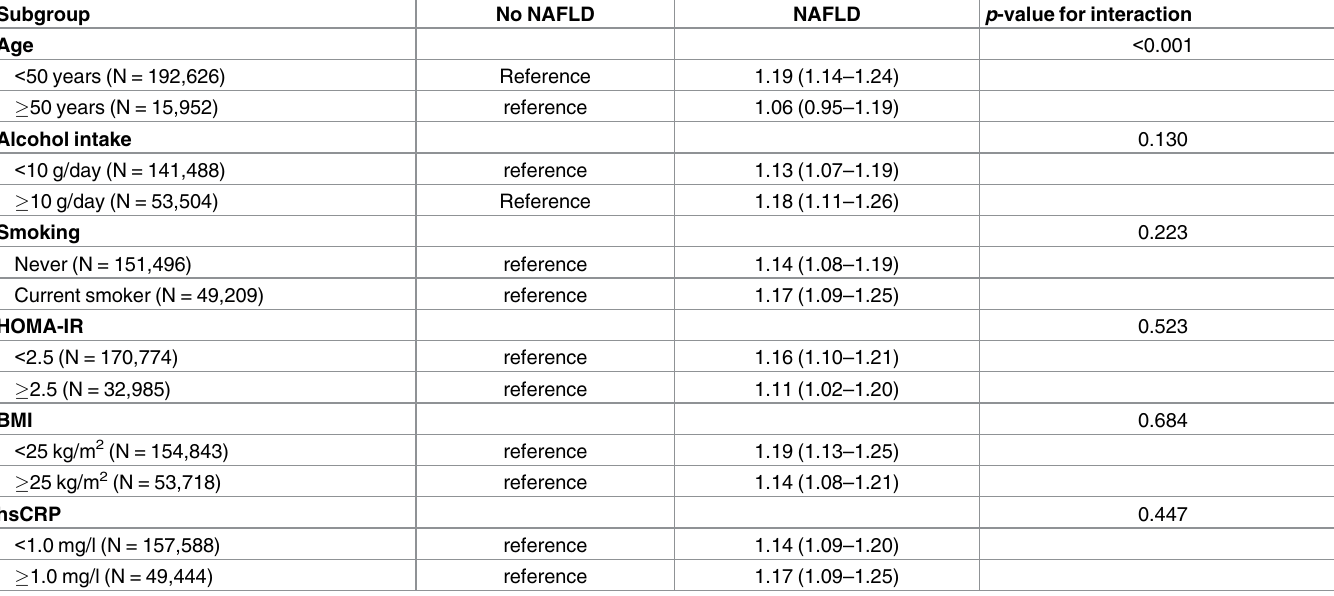
Table 3. Hazard ratios a (95% CI) for the development of nephrolithiasis according to non-alcoholic fatty liver disease (NAFLD) in clinically relevant subgroups. Subgroup No NAFLD